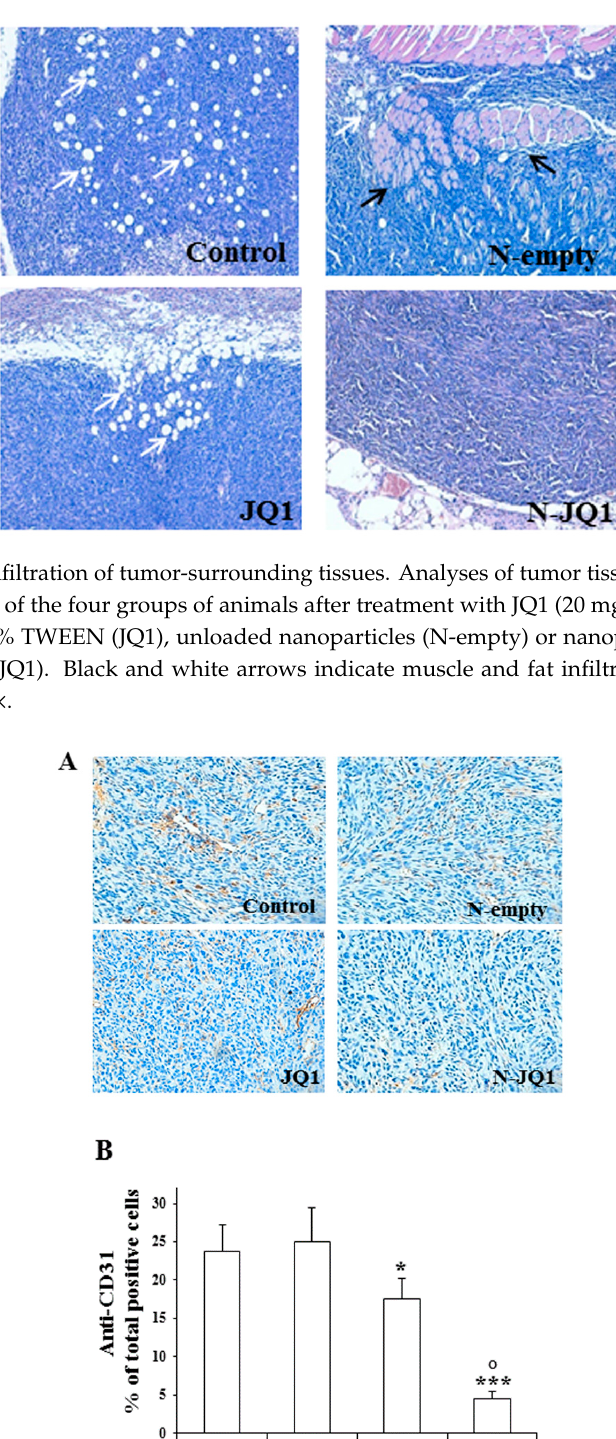
Figure 8. c-Myc mRNA levels in tumor tissues. Control, untreated mice JQ1; N-empty, unloaded nanoparticles; JQ1 (20 mg/kg) diluted in PBS + 5% PEG 400 + 5% TWEEN; N-JQ1, nanoparticles containing JQ1 20 mg/Kg. Values are expressed as means ± SD. * p < 0.05 vs. control, ** p < 0.01 vs. N-empty; ° p < 0.05 vs. JQ1.